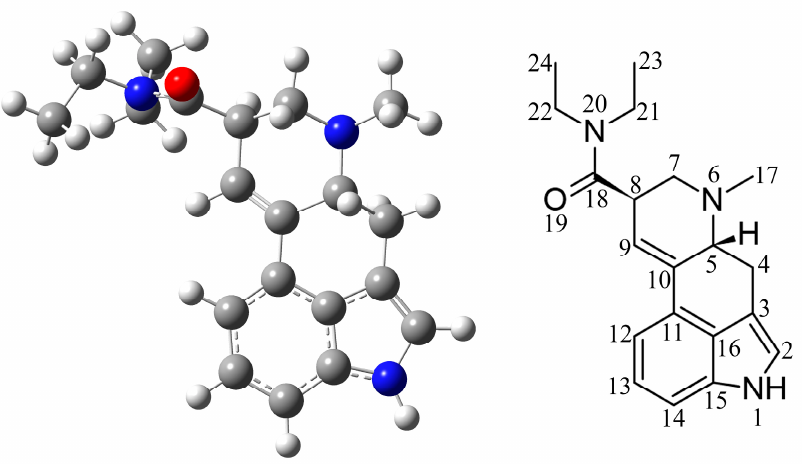
Figure 1. Optimized structure of LSD (at M05-2X/6-311++G(d,p) level of theory) with the atom numbering scheme.